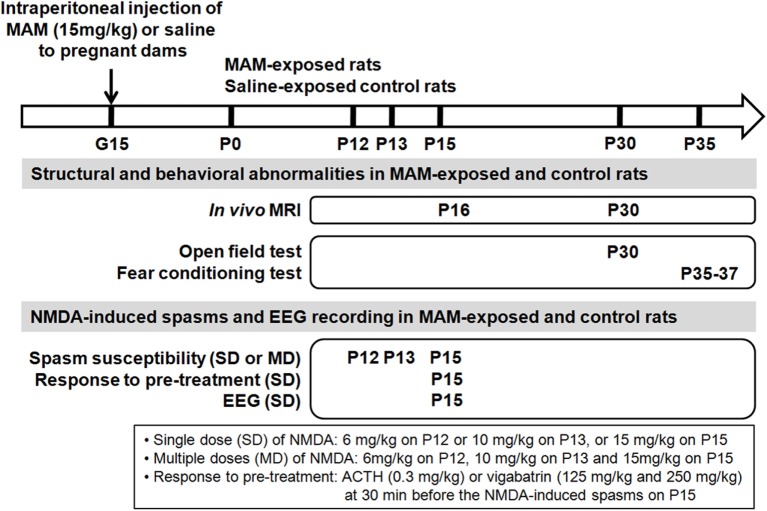
Schematic depiction of design of experiment. To produce cortical malformations to infant rats, methylazoxymethanol acetate (MAM), or saline vehicle were injected into pregnant dams at gestational day 15 (G15). The structural changes of the prenatally MAM-exposed rat brain were validated using in vivo magnetic resonance imaging (MRI) during infancy and juvenile period. Behavioral experiments were performed in MAM-exposed and the control during juvenile period. Spasms were triggered by single (SD) or multiple (MD) postnatal N-methyl-d-aspartate (NMDA) doses at infancy period in prenatally MAM-exposed rats and the controls. Spasms susceptibility, pre-treatment response to ACTH or vigabatrin, and the intractranial electroencephalography (EEG) were examined. P, postnatal day.